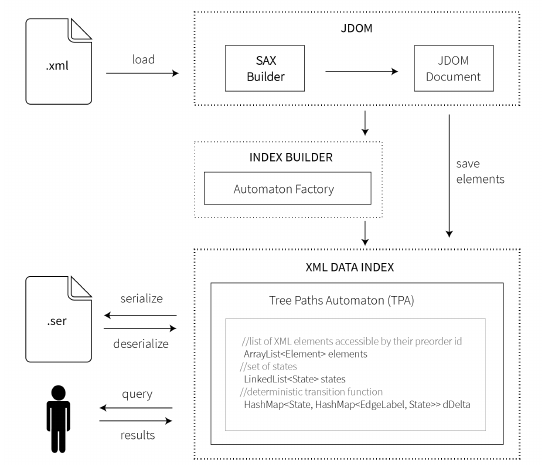
Figure 10. System architecture of tpalib . SAX, Simple API for XML; JDOM, Java-based Document Object Model for